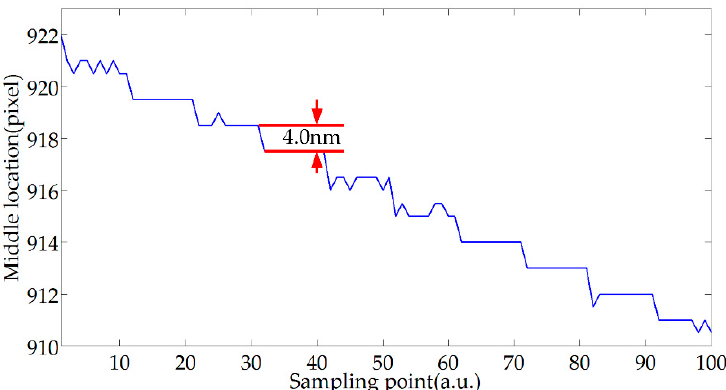
Figure 17. Test results for resolution.